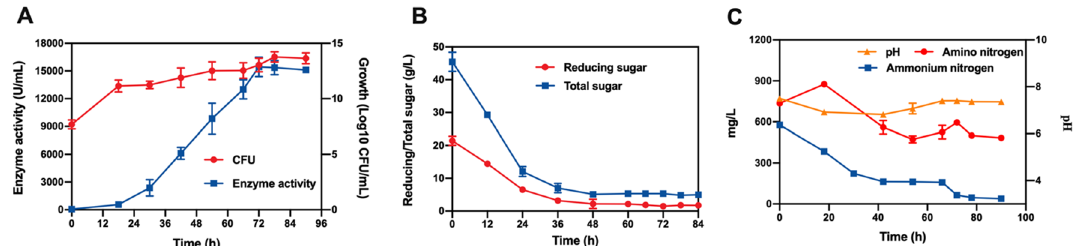
Fig. 4 Time course of fermentation in the optimum culture medium. Changes in alkaline protease activity and biomass ( A ), reducing and total sugar levels ( B ), ammonium nitrogen, amino nitrogen concentration and fermentation process pH ( C